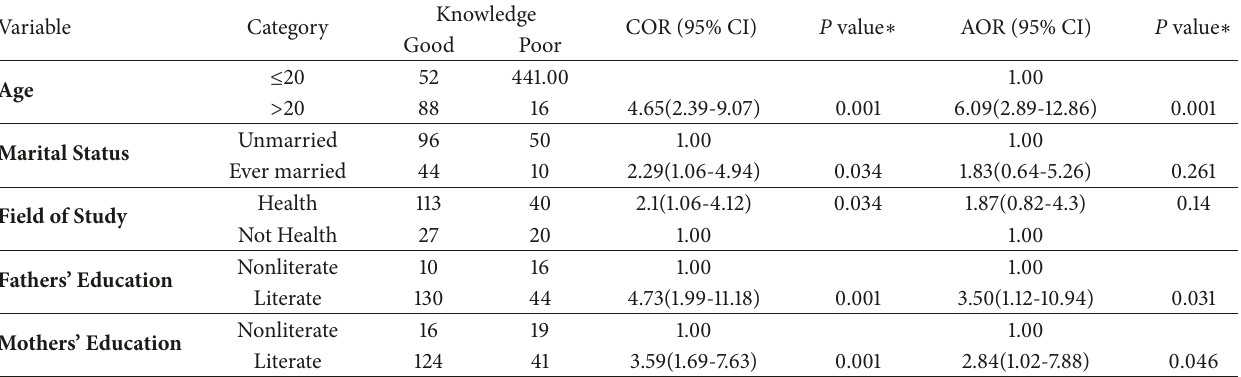
Table 4: Univariate and multivariate analysis of factors associated with knowledge of EC among female college graduating students, Harar, eastern Ethiopia, 2016